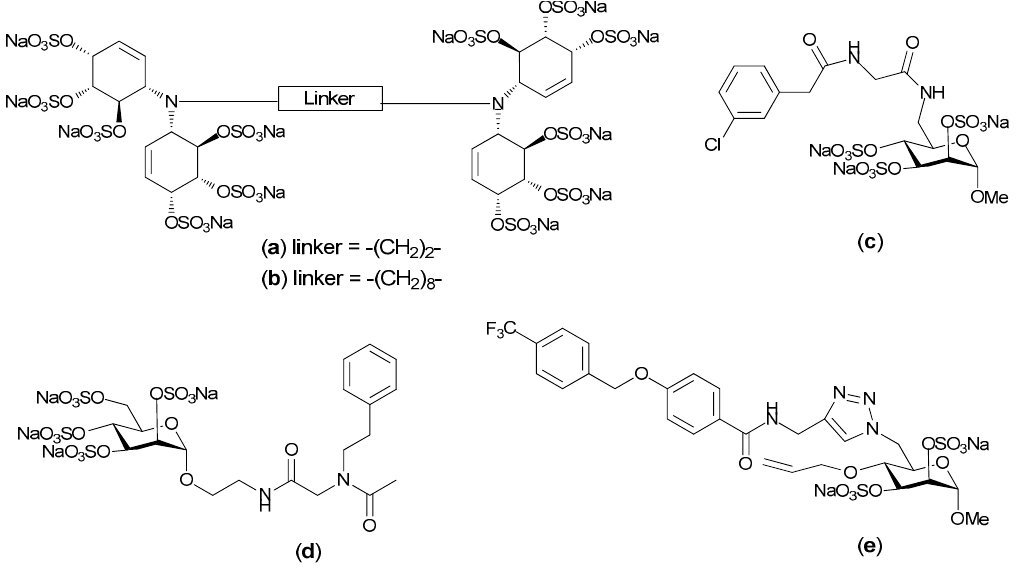
Figure 6. Small molecule heparin/heparan sulfate (HS) mimetics as potential inhibitors of fibroblast growth factors (FGF)-and/or vascular endothelial growth factor (VEGF) mediated angiogenesis for the development of novel cancer therapeutics; Structure of potent ( a , b ) linked cyclitol; ( c , d ) compounds from Ugi library; ( e ) compounds synthesized via click chemistry.